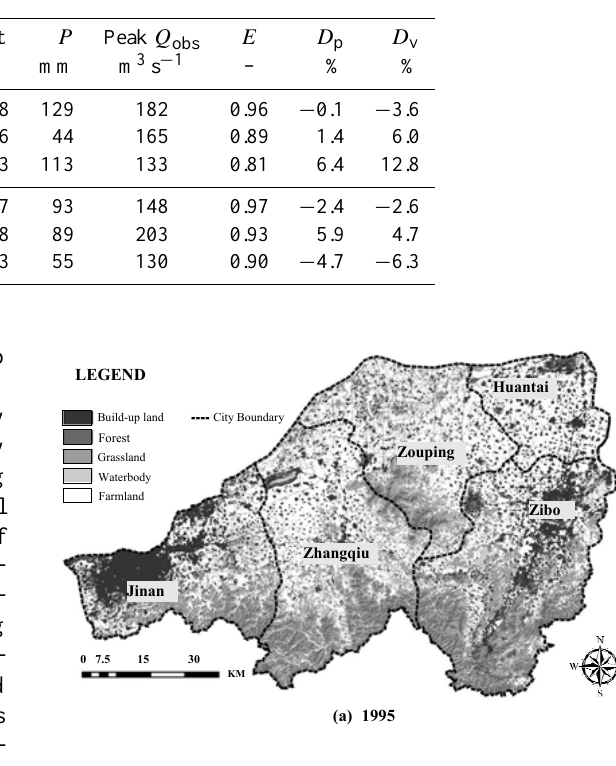
Table 1. Summary of model calibration and validation results for rainstorm events in Xiaoqing catchment.